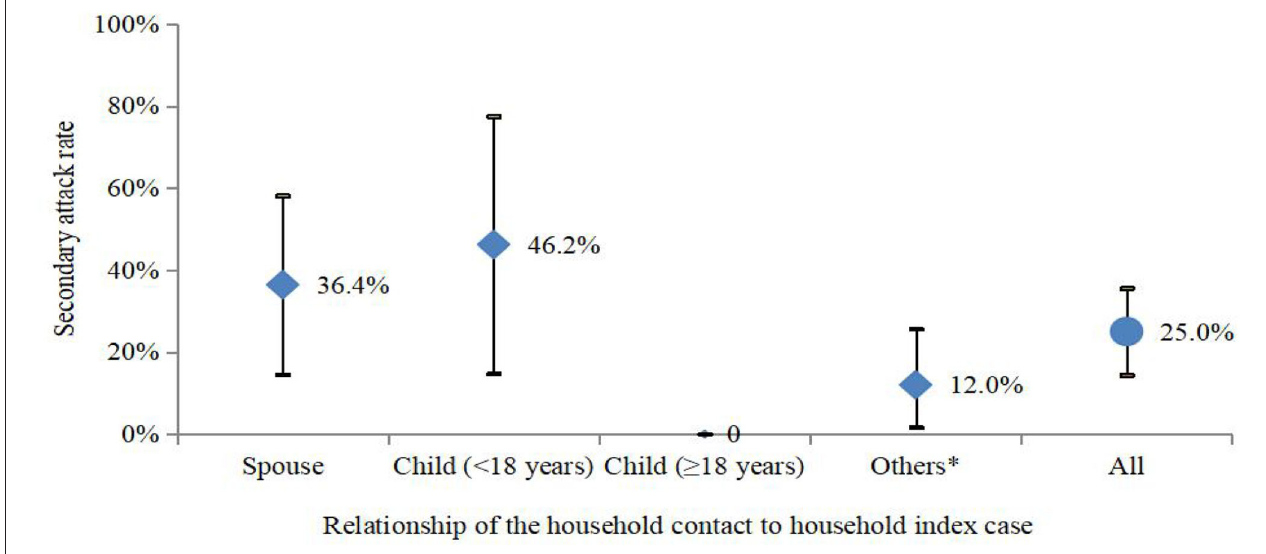
Partially vaccinated * p- value (partially Fully vaccinated * p- value (fully (IQR) vaccinated vs. (IQR) (IQR) vaccinated vs. unvaccinated)